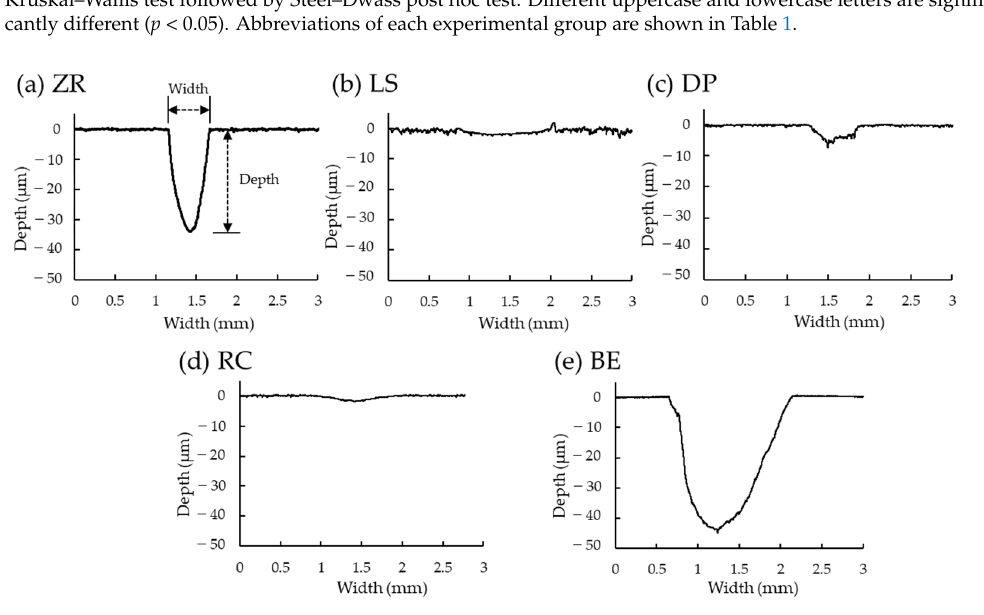
Figure 2. Typical cross-sectional profile of worn scratch of the substrate specimens. Abbreviations of each experimental group are shown in Table 1.